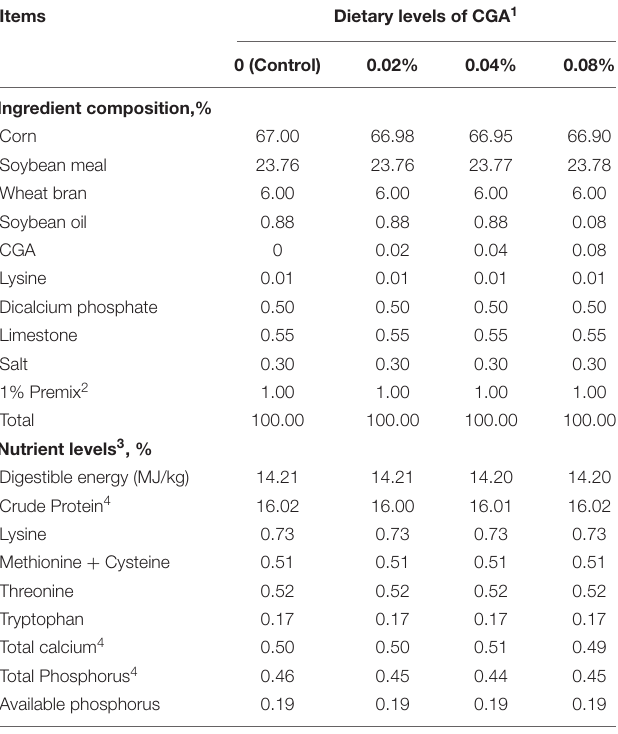
TABLE 1 | Composition and nutrient levels of the experimental diets (air-dry basis,